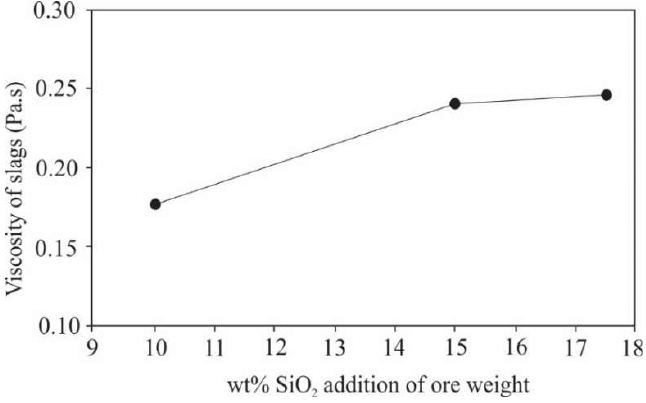
Figure 8. The viscosity of slags as a function of SiO 2 addition (wt%) of ore weight.